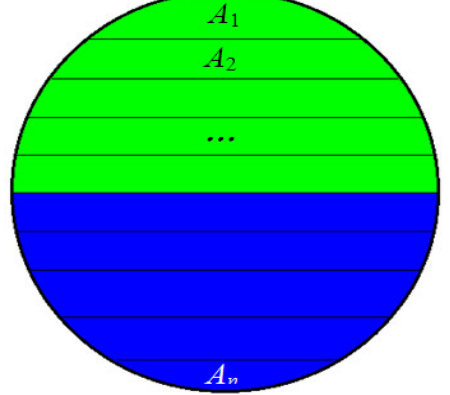
Figure 7. Schematic diagram for calculating flowrate.